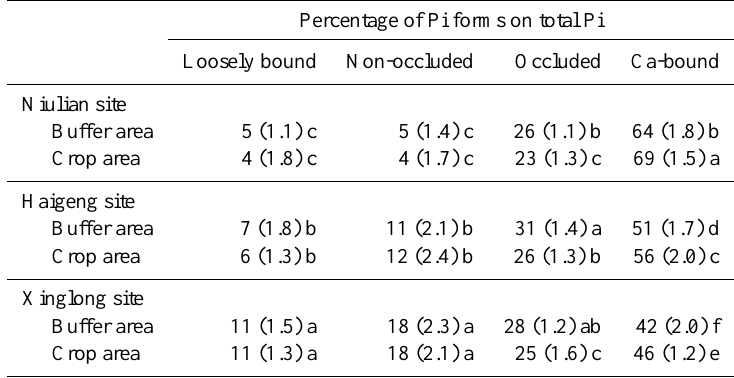
Table 1. Percentage of inorganic phosphorus forms on total Pi in the 0–20cm soil layer of different sites.